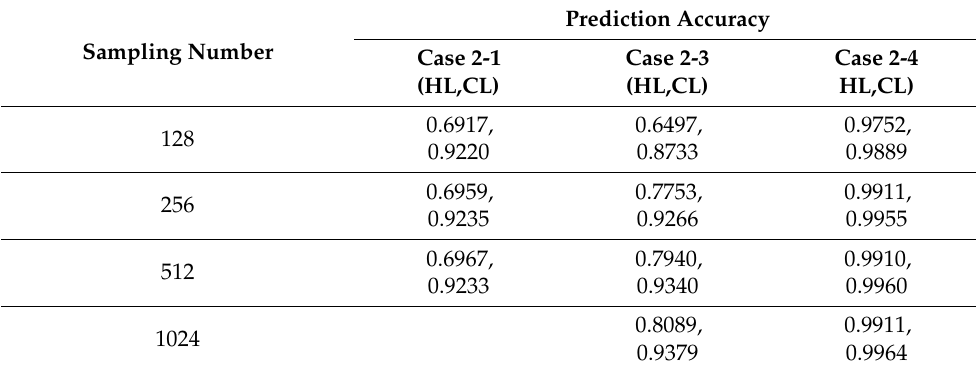
Figure 6. ( a ) Comparison of building heating load prediction accuracy for the “LHS validation set” using LHS and FFD (sampling number: 512). ( b ) Comparison of building cooling load prediction accuracy for the LHS validation set using LHS and FFD (sampling number: 512). Table 6. Prediction accuracy for the LHS validation